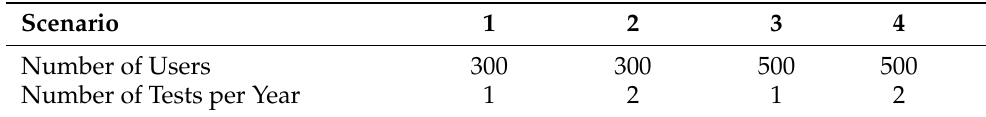
Table 2. Four different scenarios.